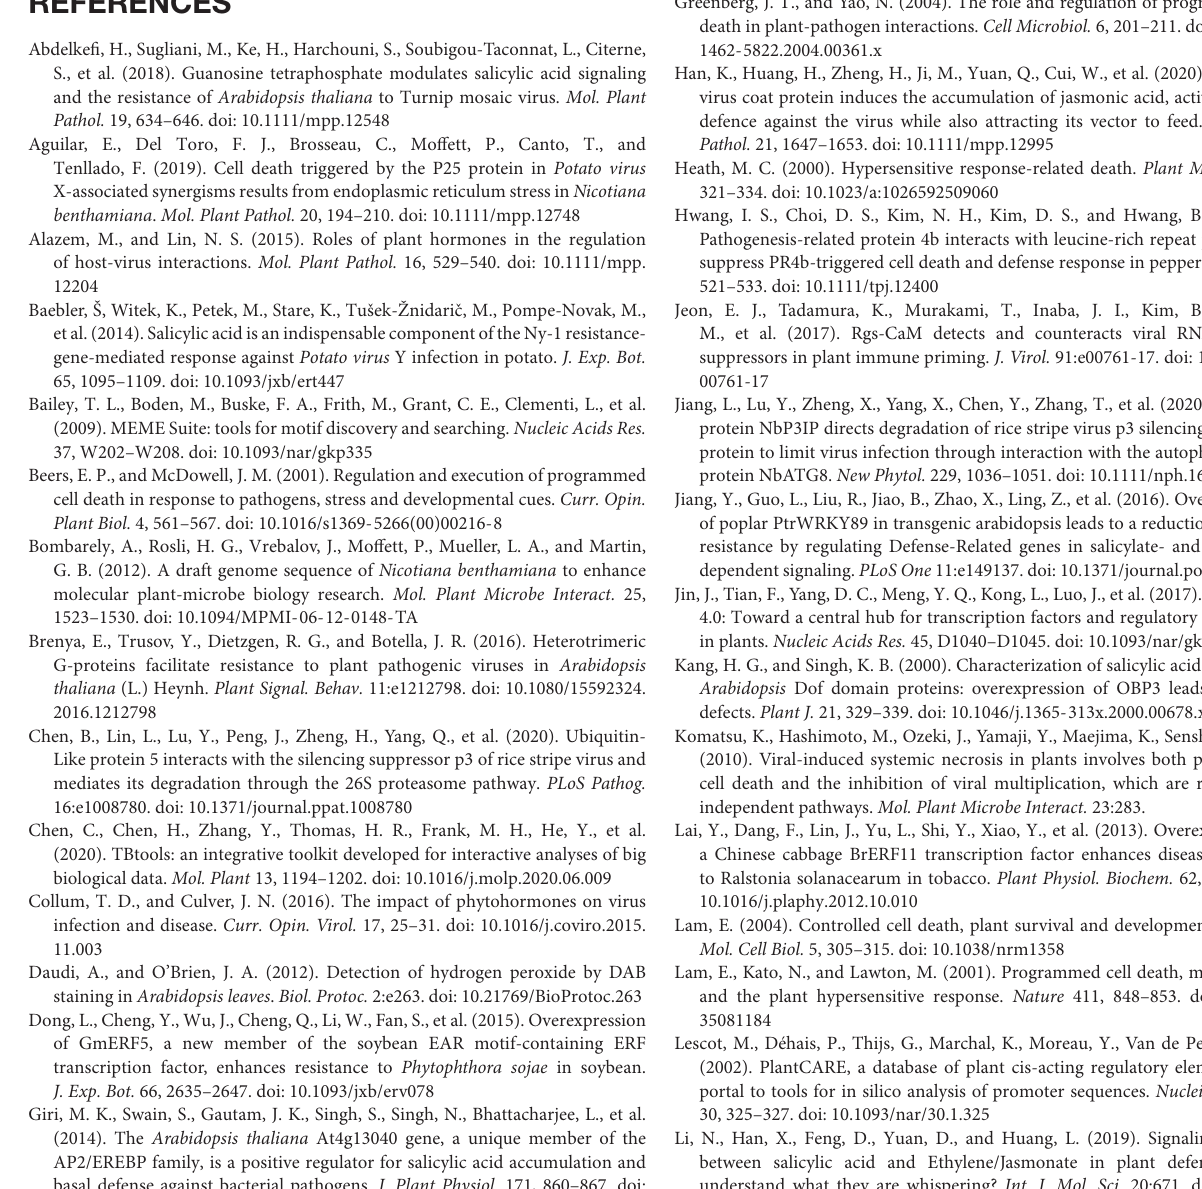
Supplementary Table 1 | Information of transcriptome sequence. Supplementary Table 2 | Primers used in this study.